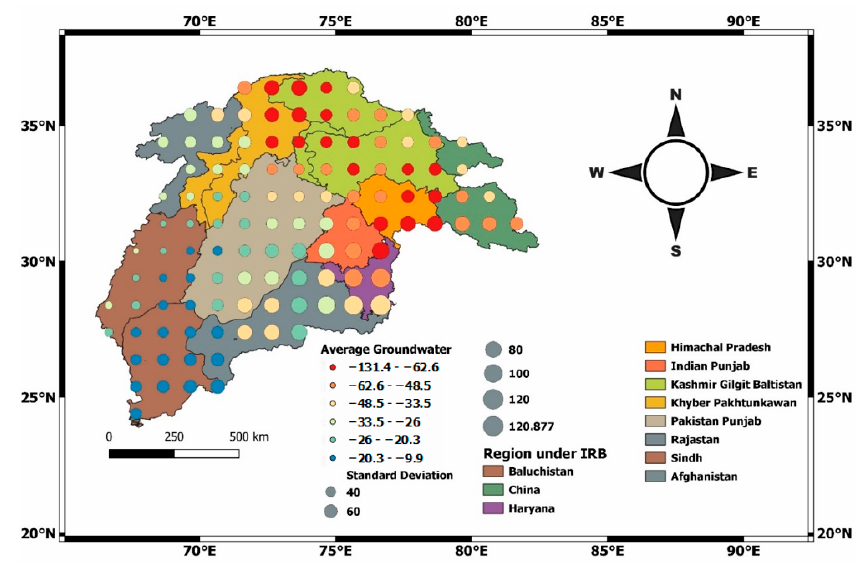
Figure 4. Spatial analysis of the time-averaged GWCs in IRB.